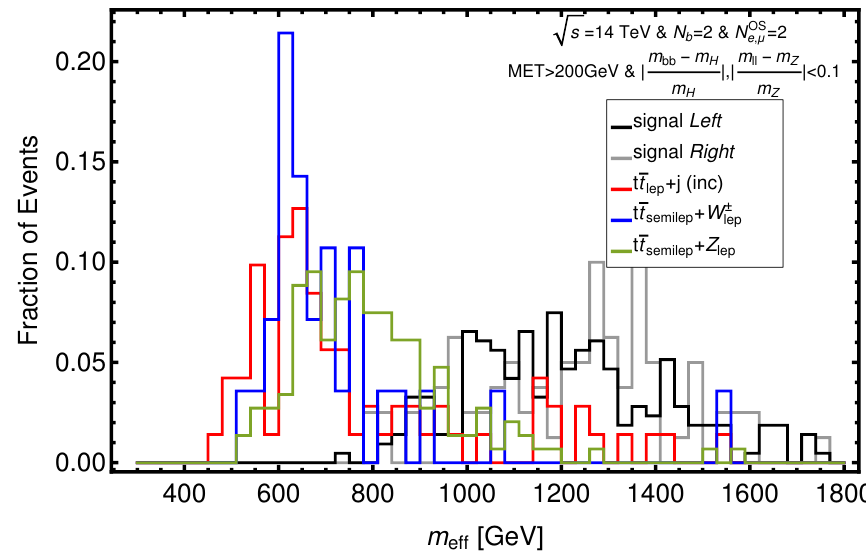
over samples of signal and backgrounds without T